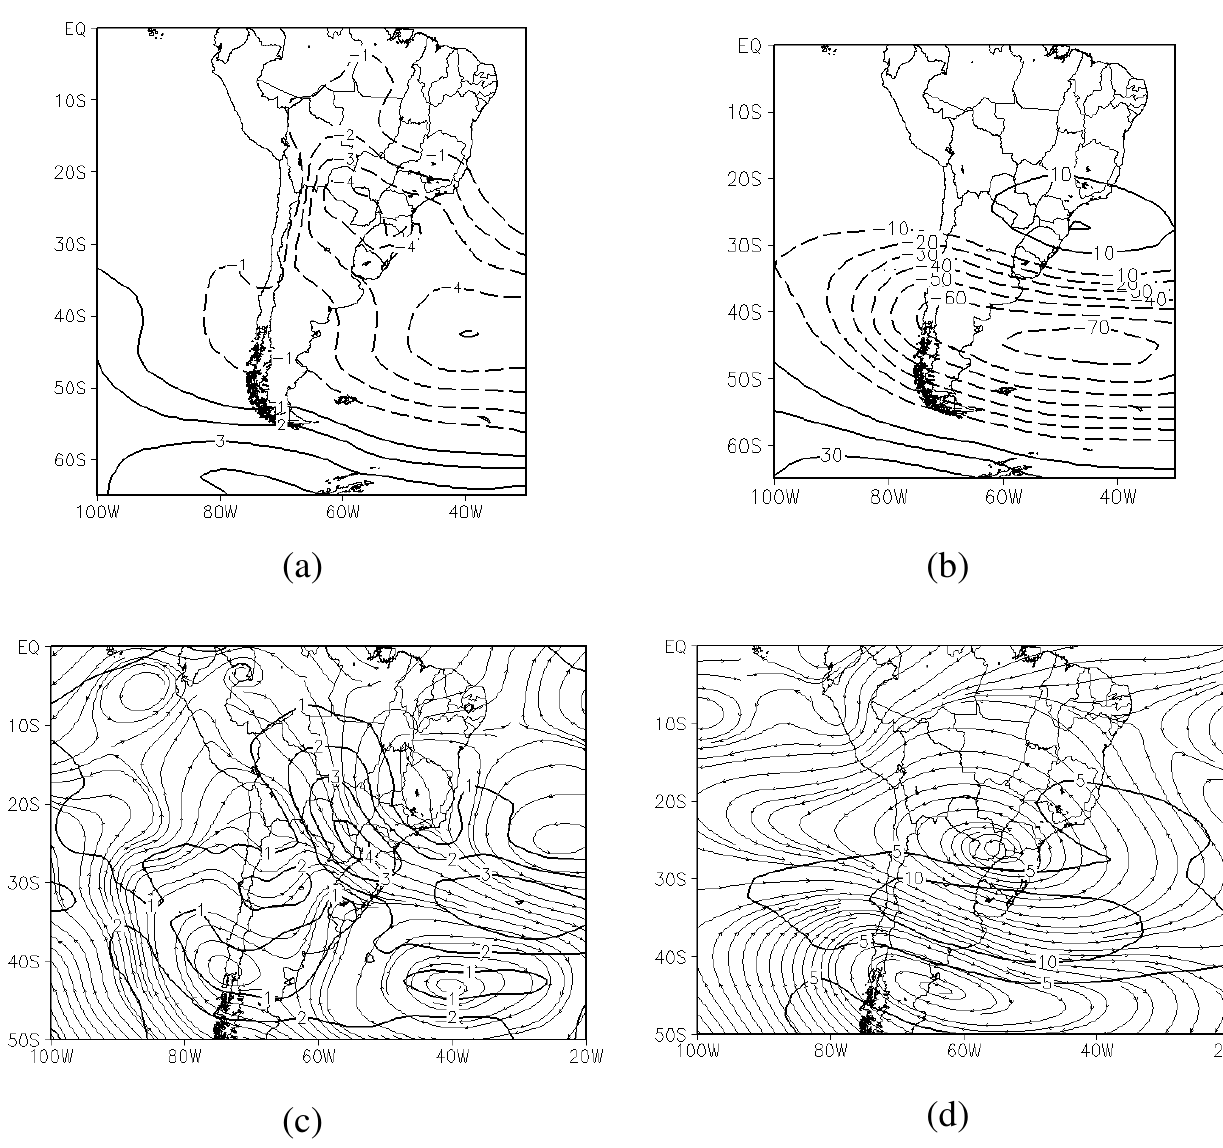
Fig. 6. Composite mean (a) surface pressure anomaly (hPa), (b) 500-hPa geopotential anomaly (m), (c) 850-hPa wind anomaly, and (d) 250-hPa wind anomaly for 17 strong WDSs. Dark lines in panels (c) and (d) are isotachs (ms − 1 ) and light lines are streamlines.